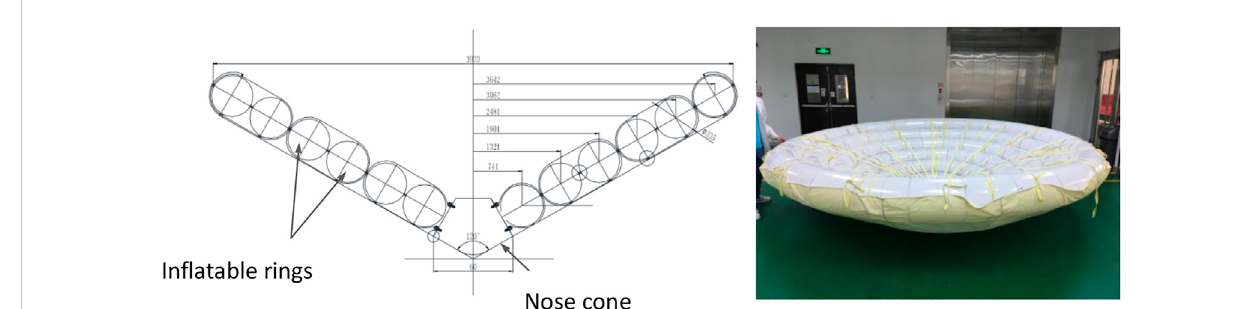
FIGURE 7 Schematic diagram of deployable aerodynamic dissymmetric section and expansion state.